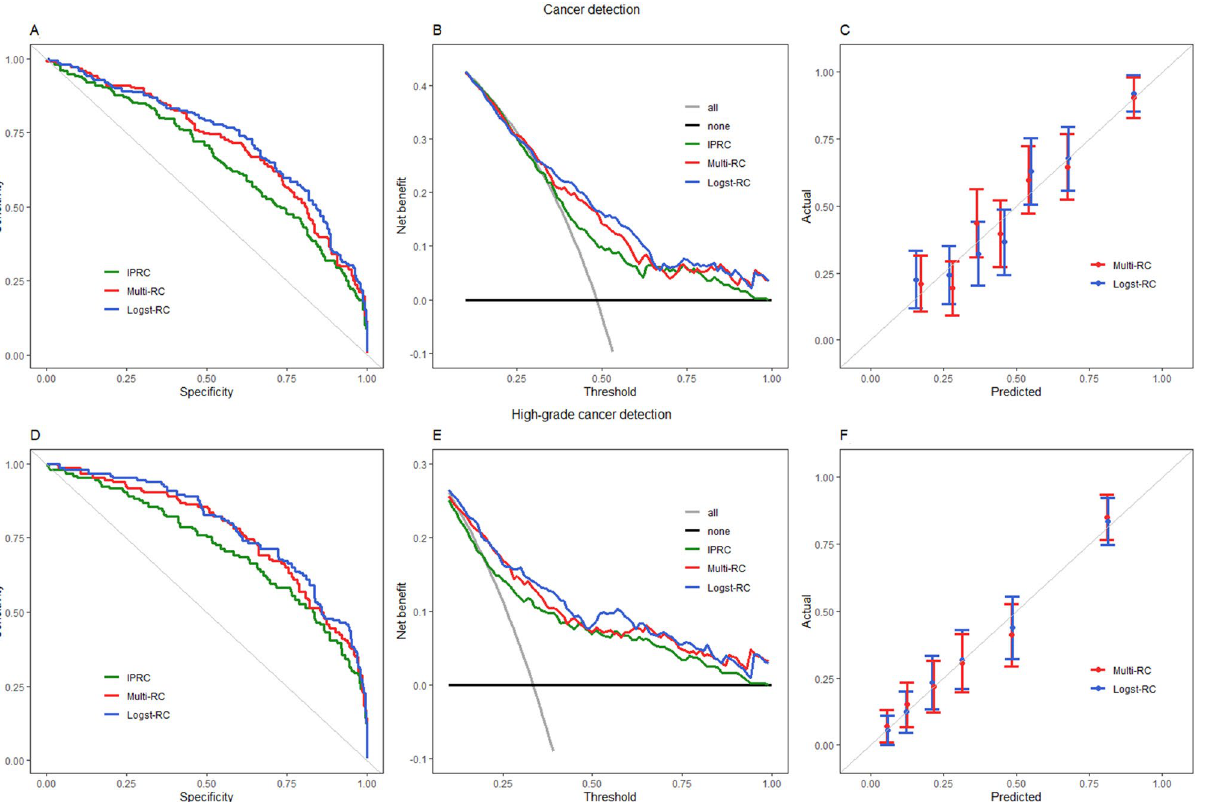
Figure 1. The receiver operating characteristic (ROC) curves ( A , D ) and decision curves ( B , E ) represent the discriminative ability of IPRC (green), Multi-RC (red) and Logst-RC (blue) in diagnosis of cancer ( A , B ) and high-grade cancer ( D , E ). Calibration curves are represented in ( C , F